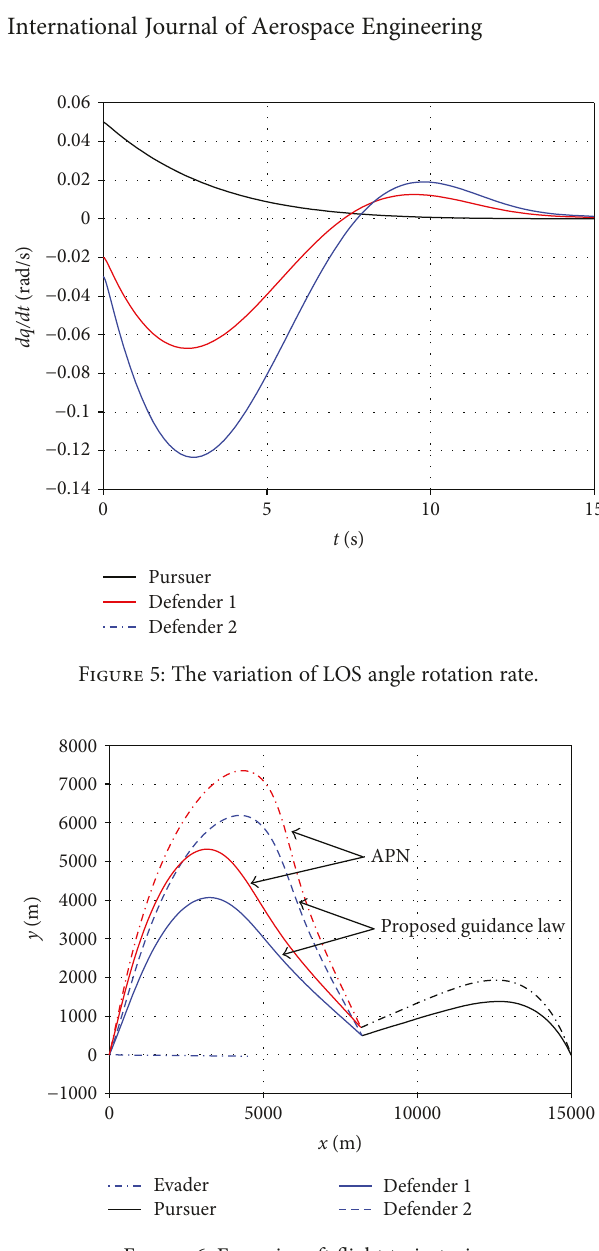
Figure 6: Four aircraft fl ight trajectories.